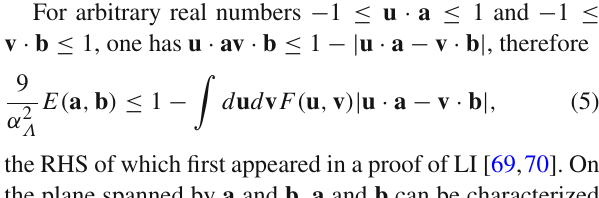
direction is the direction of p e − × p Λ . By boosting this frame, the rest frames of Λ and ¯ Λ can be obtained